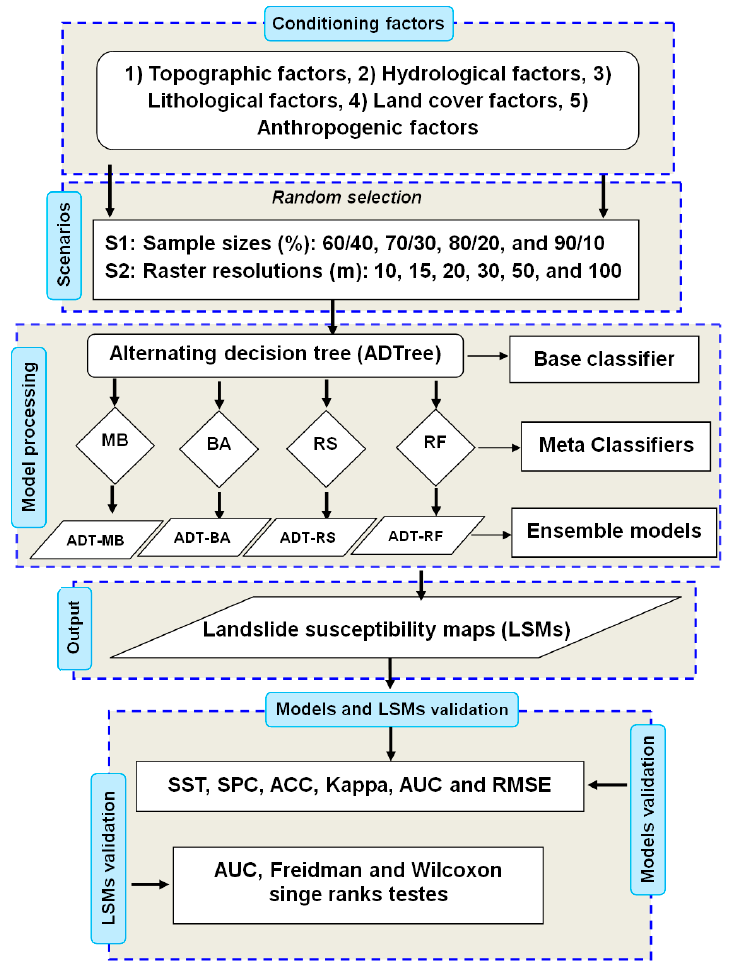
Figure 3. Flowchart of modeling process and methodology used in this study.